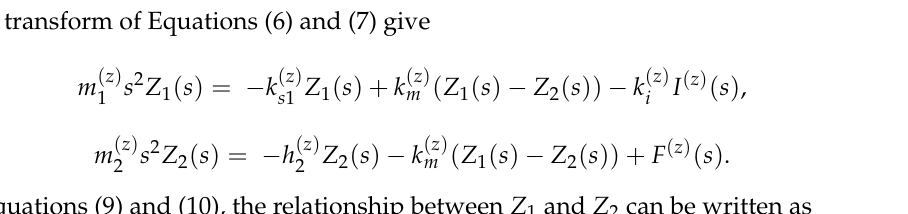
Figure 4. Block diagram of the vertical direction force measurement [23].